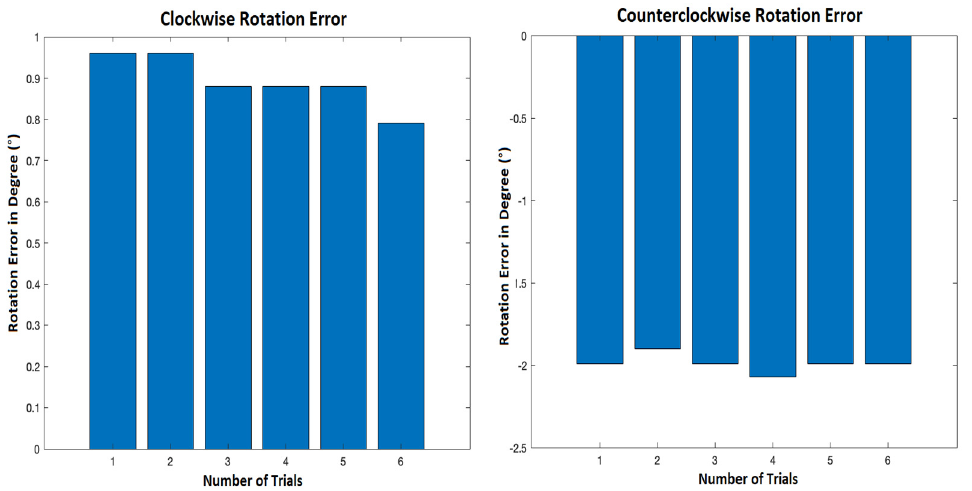
Figure 3. Clockwise and counterclockwise rotation error.